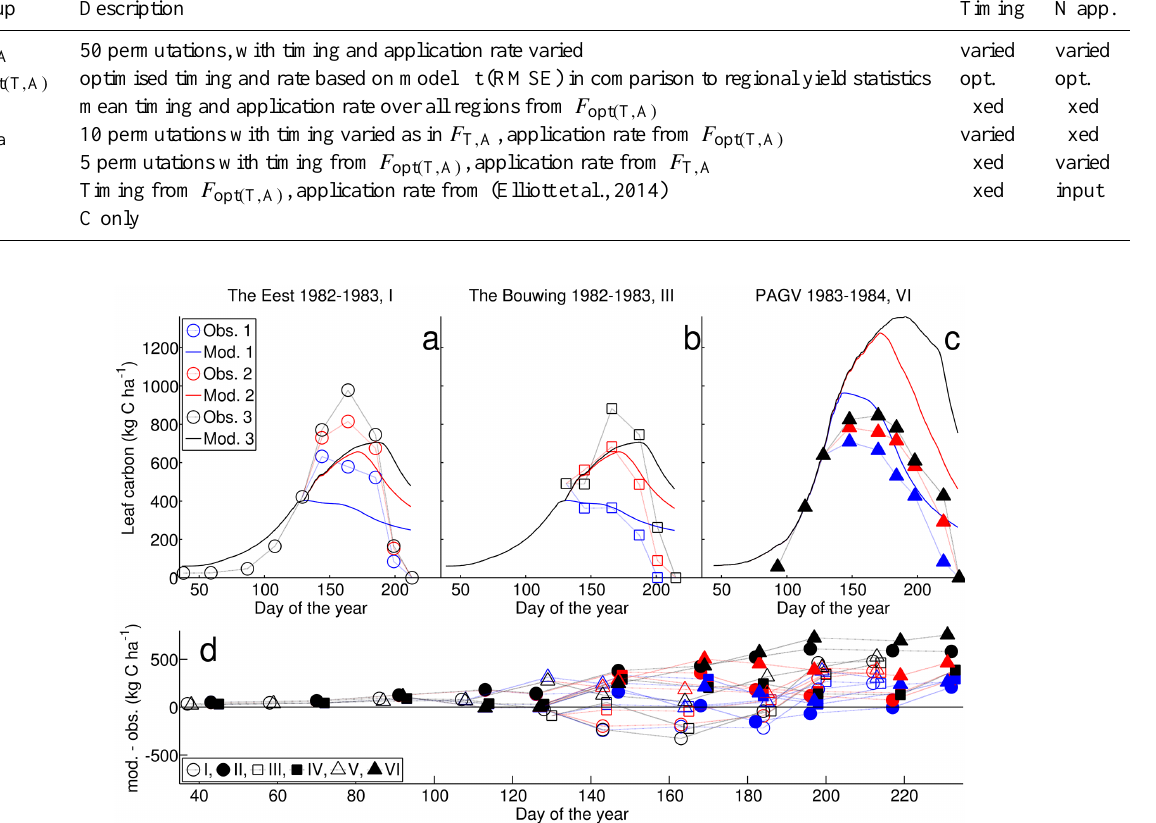
Figure 2. (a–c) Observed (thin lines) and simulated (thick lines) leaf C for the Eest and Bouwing for the season 1982–1983 and PAGV for the season 1983–1984, for three example plots with different levels of N fertiliser input. (d) The difference between observed and simulated leaf C for three different levels of fertiliser application for the Bouwing, the Eest and PAGV (Netherlands) for seasons 1982–1983 and 1983–1984 (Groot and Verberne, 1991). Blue symbols indicate lowest levels of fertilisation; red represent medium and black symbols a high N fertiliser input. Open symbols are for the season 1982–1983, and closed symbols are for the season